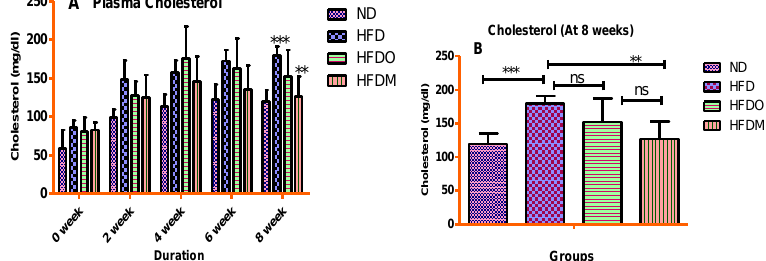
Figure 8. Treatment with MESK ameliorated HFD-induced hypercholesteremia in the diet-induced obese mouse model. ( A ) Change in the plasma cholesterol during the study period and ( B ) change in cholesterol level after the eighth week. (N = 5, *** p < 0.001 between ND and HFD, ** p = 0030 between HFD and HFDM). (ND: normal diet, HFD: high-fat diet, HFDO: HFD + Orlistat; HFDM: HFD + MESK).